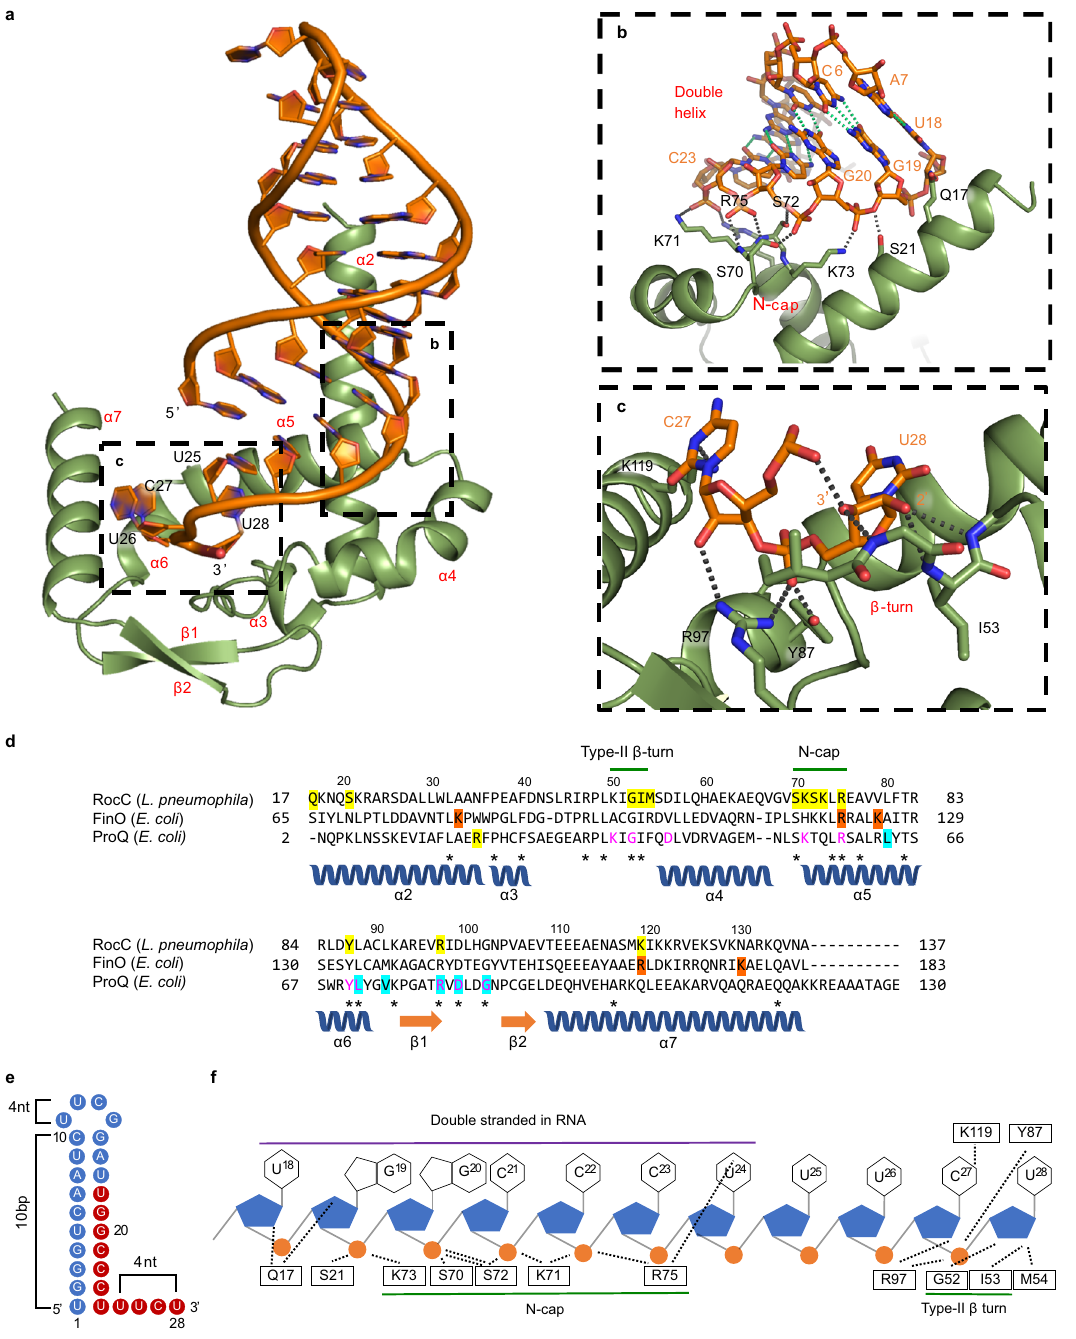
Fig.2|StructuralanalysisoftheProQ/FinOdomainofRocCboundtoaRocR SL3 variant. a Crystal structure of RocC 14 − 126 /RocR 9bp-tet complex. Dotted boxes indi- catethemaininteractionsbetweenprotein – RNA. b , c arezoomed-inviewsfrom( a ). Black dotted lines indicate hydrogen bonding between protein and RNA. Green dotted lines indicate hydrogen bonding for the base pairing. d Structure-based sequence alignment of the ProQ/FinO domains of RocC, FinO, and ProQ. Yellow highlights in RocC indicate residues in contact with RocR 9bp-tet in the crystal structure. Asterisks indicate highly conserved residues across the three proteins. Orange highlights in the FinO sequence indicate residues that show strong cross-